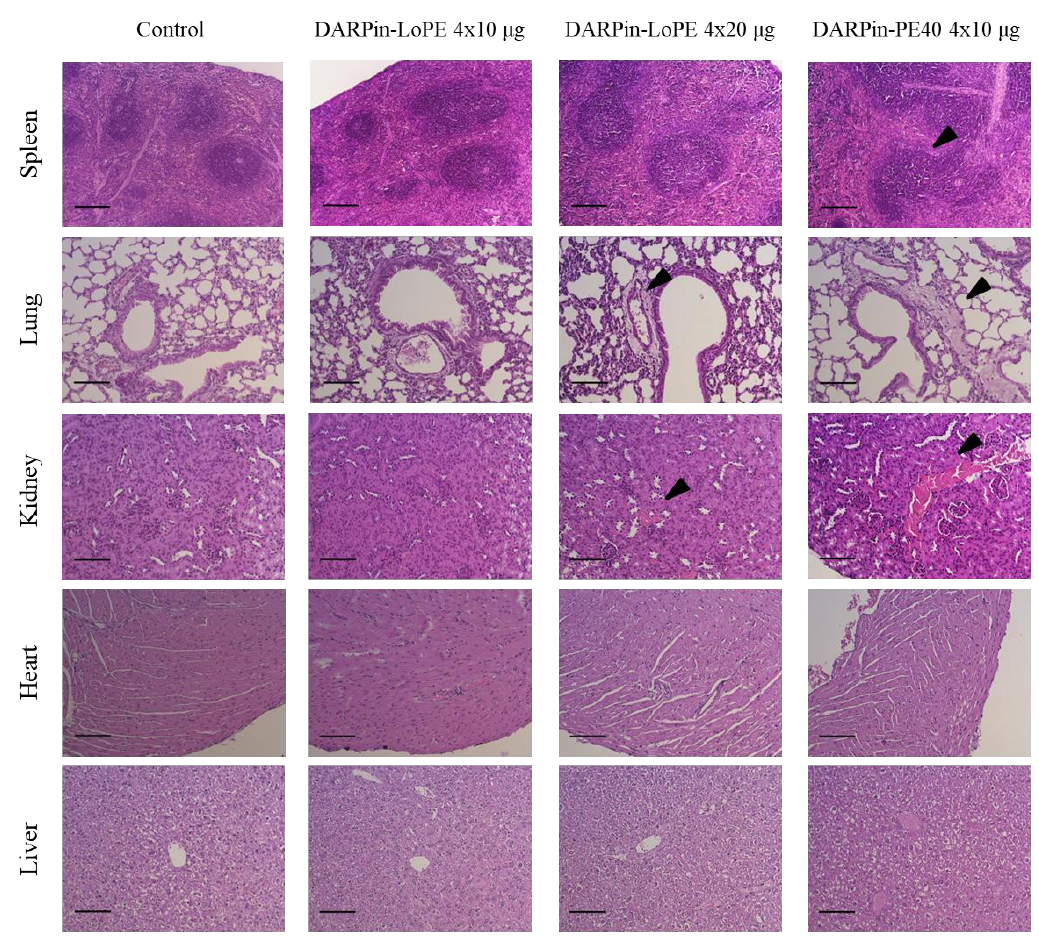
Figure 4. Hematoxilin and eosin staining of organ sections of mice in di ff erent groups. Degenerative tissue lesions upon treatment with the targeted toxins are indicated with arrows. In mice treated with 4 × 10 µ g DARPin-PE40 the portion of the white pulp of spleen is increased in a zone of periarteriolar sheaths. In mice treated with 4 × 10 µ g DARPin-PE40 or 4 × 20 µ g DARPin-LoPE the peribronchovascular space is dilatated in the lungs, as well as hemorrhage and necrosis sites are observed in kidneys. For spleen images scale bar is 200 µm, magnification ×100; for lung, kidney, heart and liver scale bar is 100 µm, magnification ×200.